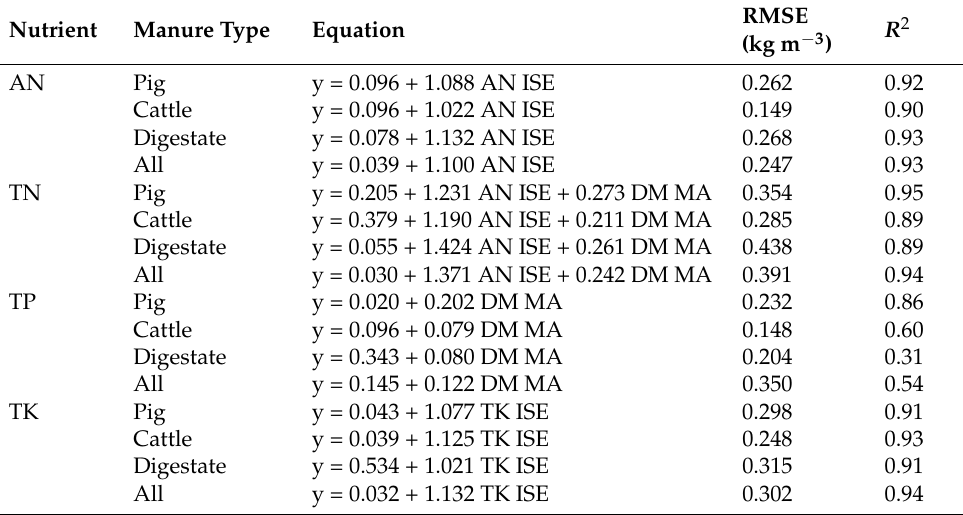
Table 2. Regression models for the different sample sets: laboratory measurements versus quick tests with coefficients of determination ( R 2 ) and root mean square errors (RMSE) (significance level for all regressions p < 0.001).